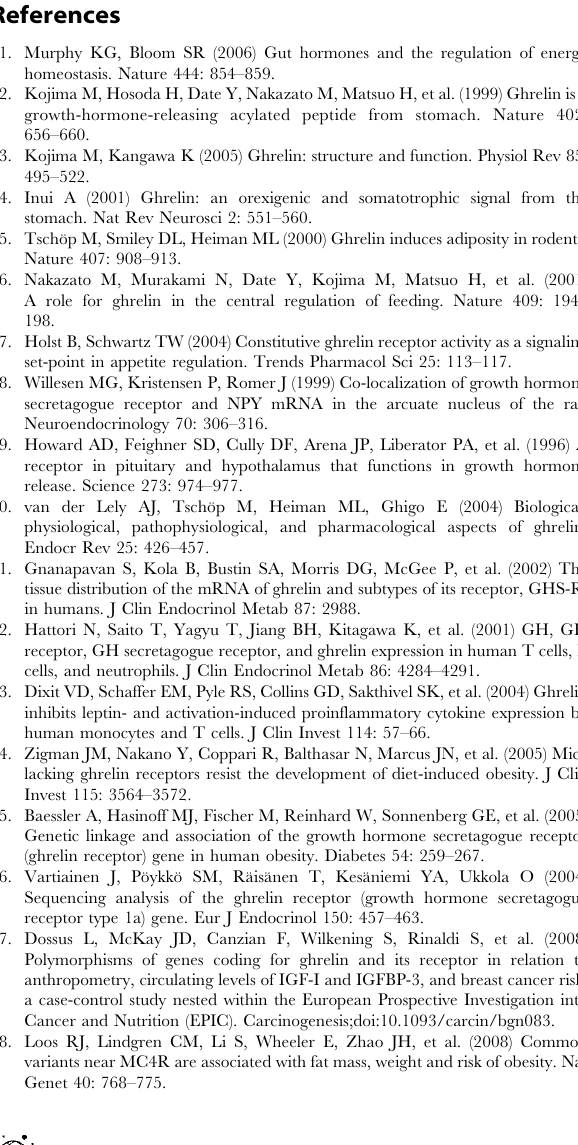
Table S1 Oligonucleotides used in gelshift assays. List of oligonucleotides which were used to test the difference in protein binding among different GHSR SNP